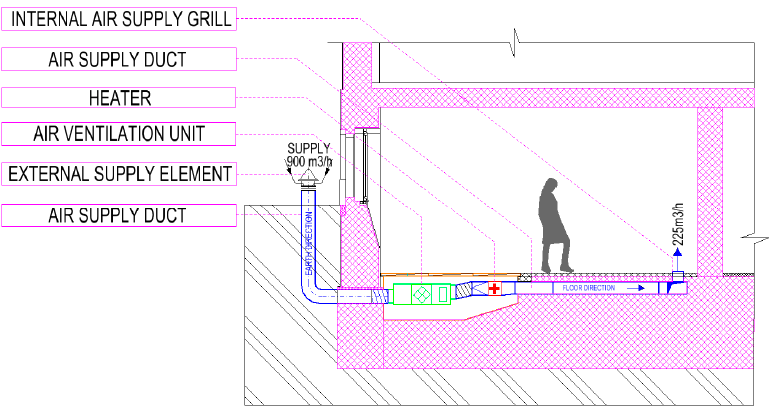
Figure 4. Cross-section of the investigated room with the designed ducts of the HVAC system.